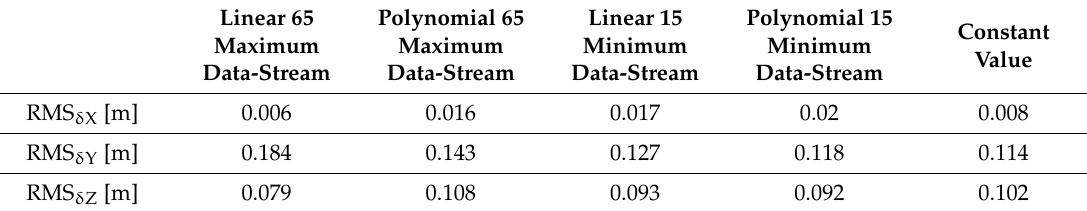
Table 1. The RMS values of the time series of geocentric corrections referring to an out-of-date navigation message (GPS G13).